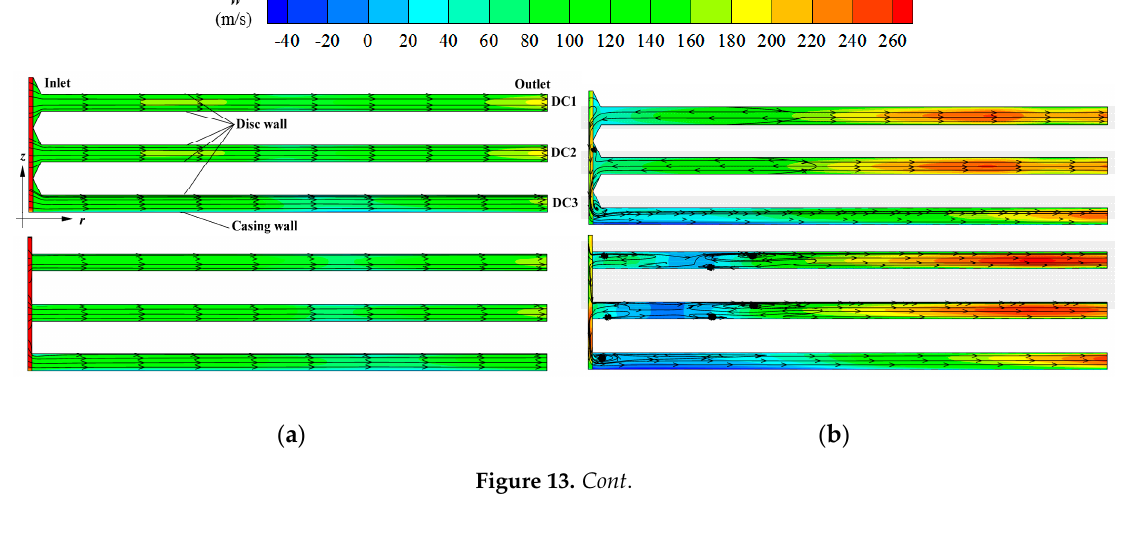
Figure 12. Streamlines and Mach number distributions on the middle of DC1 and DC3 for the one-to-many turbine models with different disc tips. ( a ) DC1 for OTM-B; ( b ) DC3 for OTM-B; ( c ) DC1 for OTM-T-2; ( d ) DC3 for OTM-T-2.